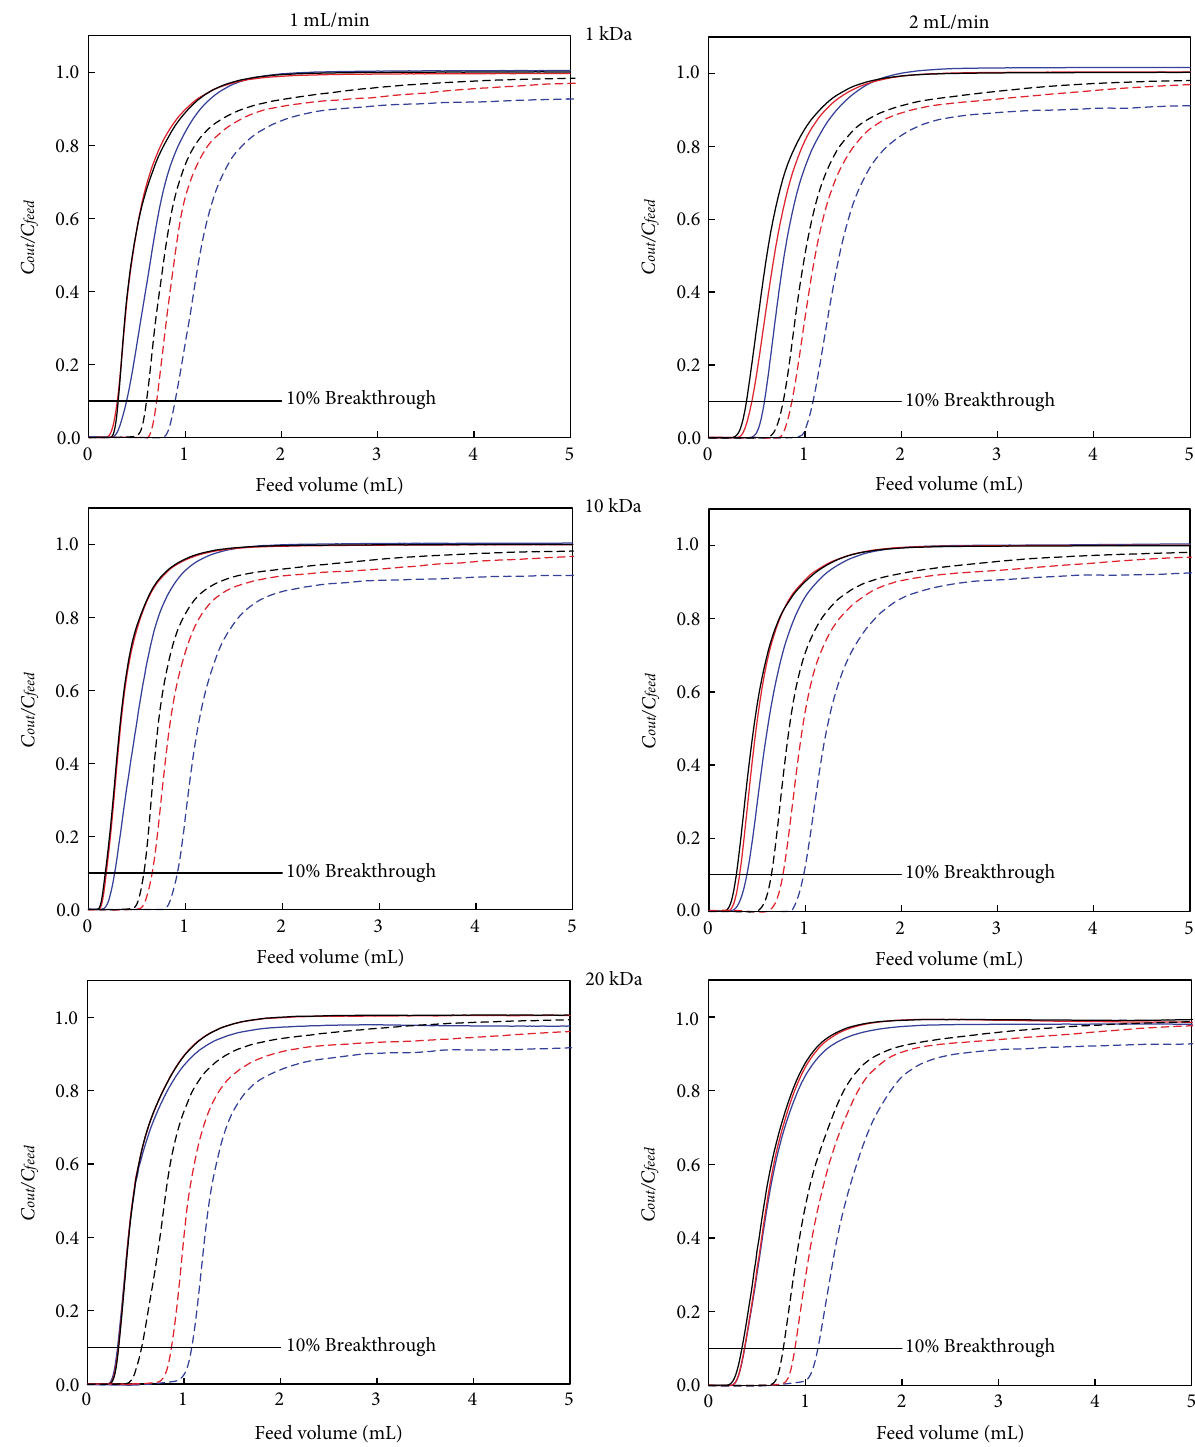
Figure 1: Breakthrough curves of PEGylated monoliths using BSA. The two ammonium sulfate concentrations used were 1.5 and 2.0 M and are represented by solid lines and dashed lines respectively. The color of the lines indicate the different BSA concentrations tested (blue lines, 1.0 mg/mL; red lines, 2.0 mg/mL and black lines, 3.0 mg/mL). Each column of graphs corresponds to each of the two Flow rates used (1.0 and 2.0 mL/min). All presented curves are the mean of three